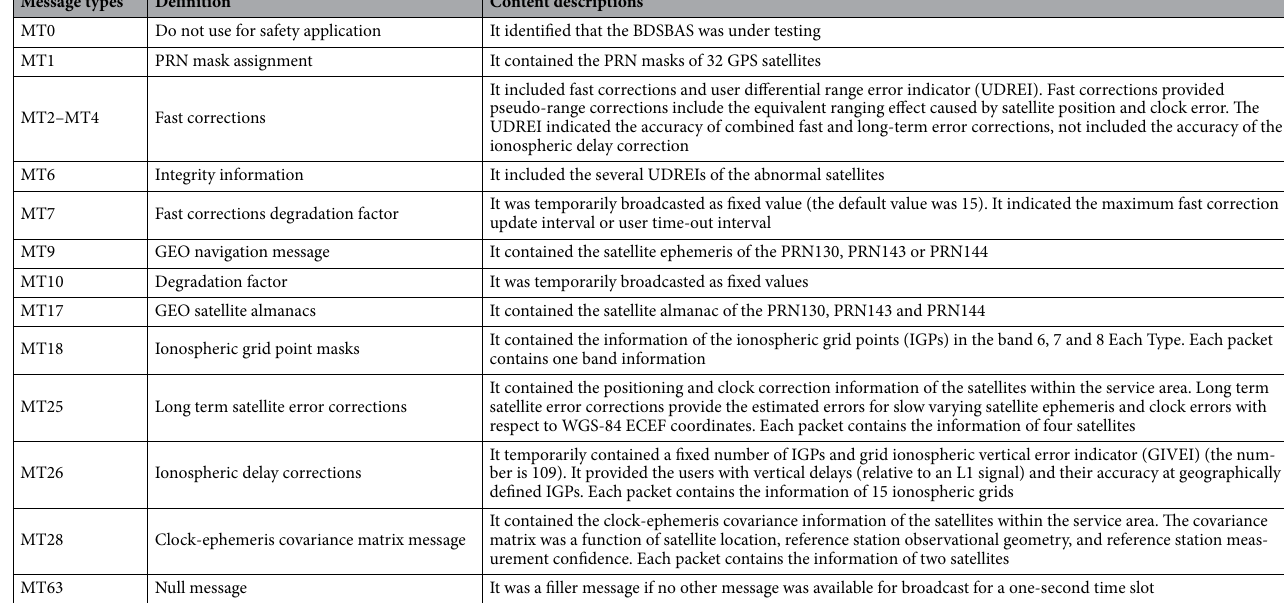
Table 1. The message types and content broadcasted in the BDSBAS-B1C